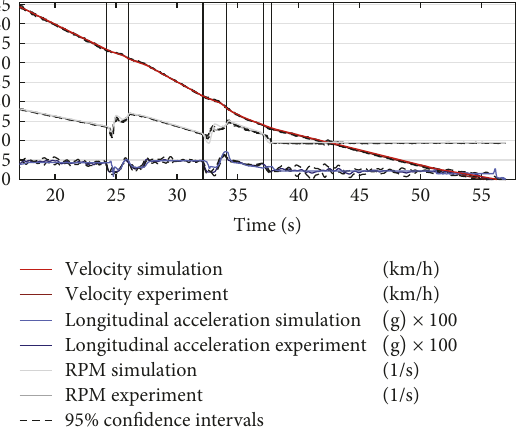
longitudinal acceleration and the rpm curvature while clutch operating would get unsharp. Thus, we introduce the points in time when the clutch is opened and closed as reference points for splitting and aligning the data. In this way, the state transition between engaged gears and gear switching operations is sharpened and clearly exposed for